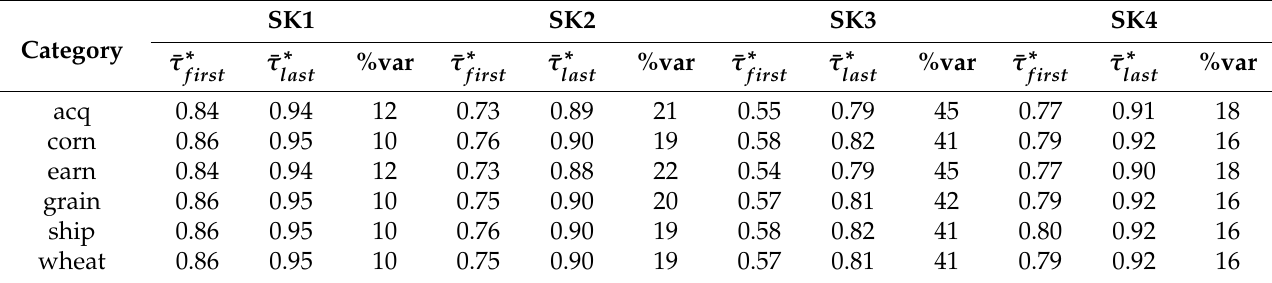
Table A2. Average of the computed collective concordance indices per category ( m =